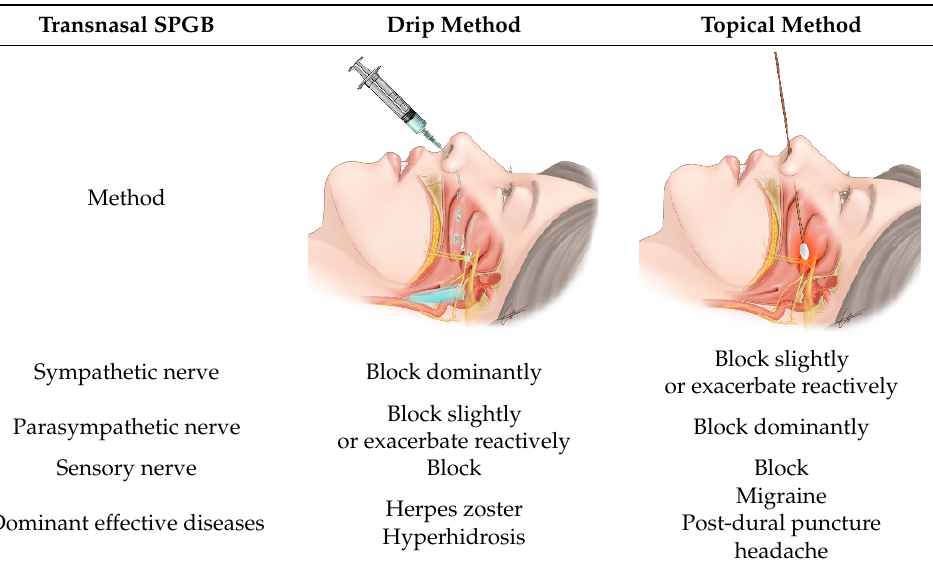
Table 6. Estimation of drip and topical method effect for sympathetic, parasympathetic, sensory nerve, and effective diseases.